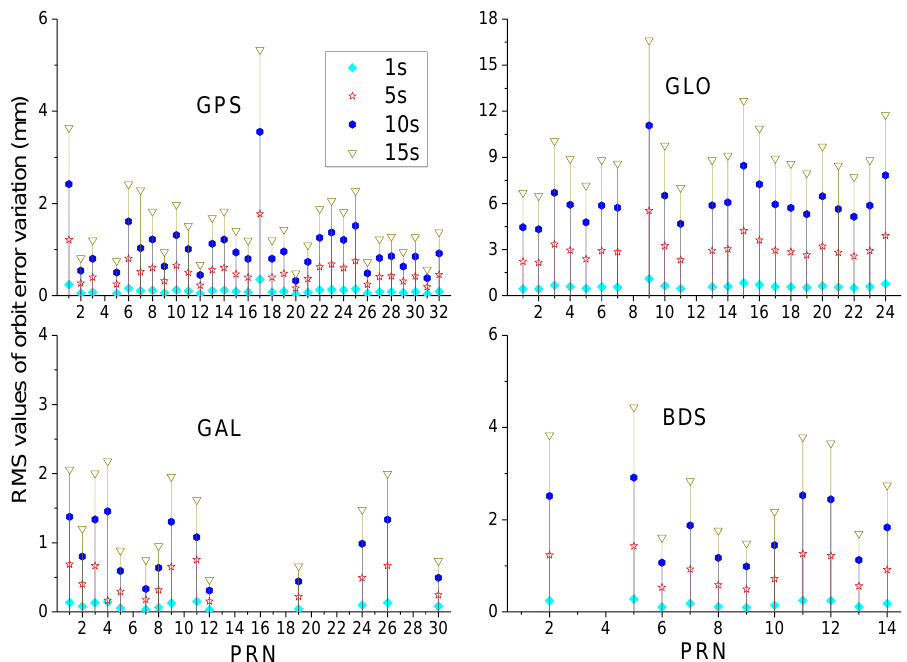
Figure 6. RMS result for 1, 5, 10, and 15 s latency variation of broadcast orbit error on 10 January 2018.